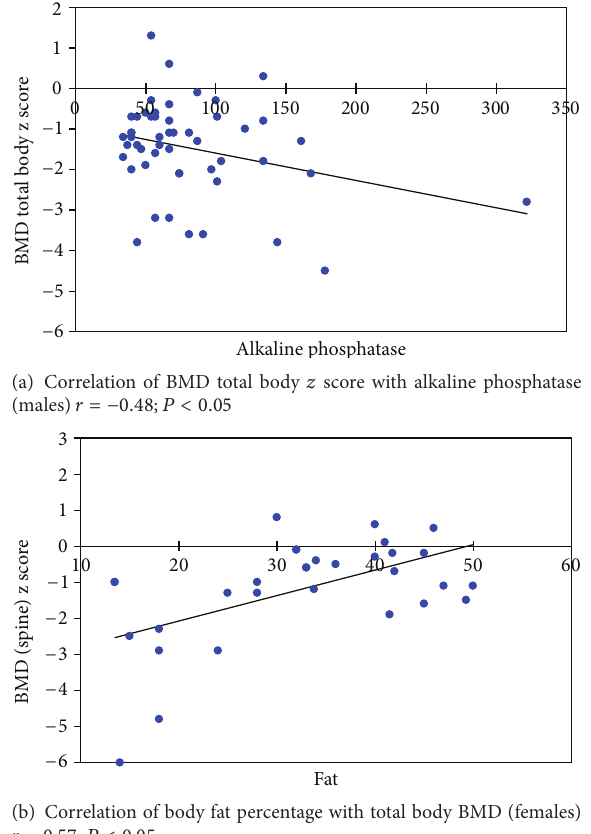
Figure 2: Correlation of total body BMD 𝑧 score with alkaline phosphatase in males and with body fat percentage in